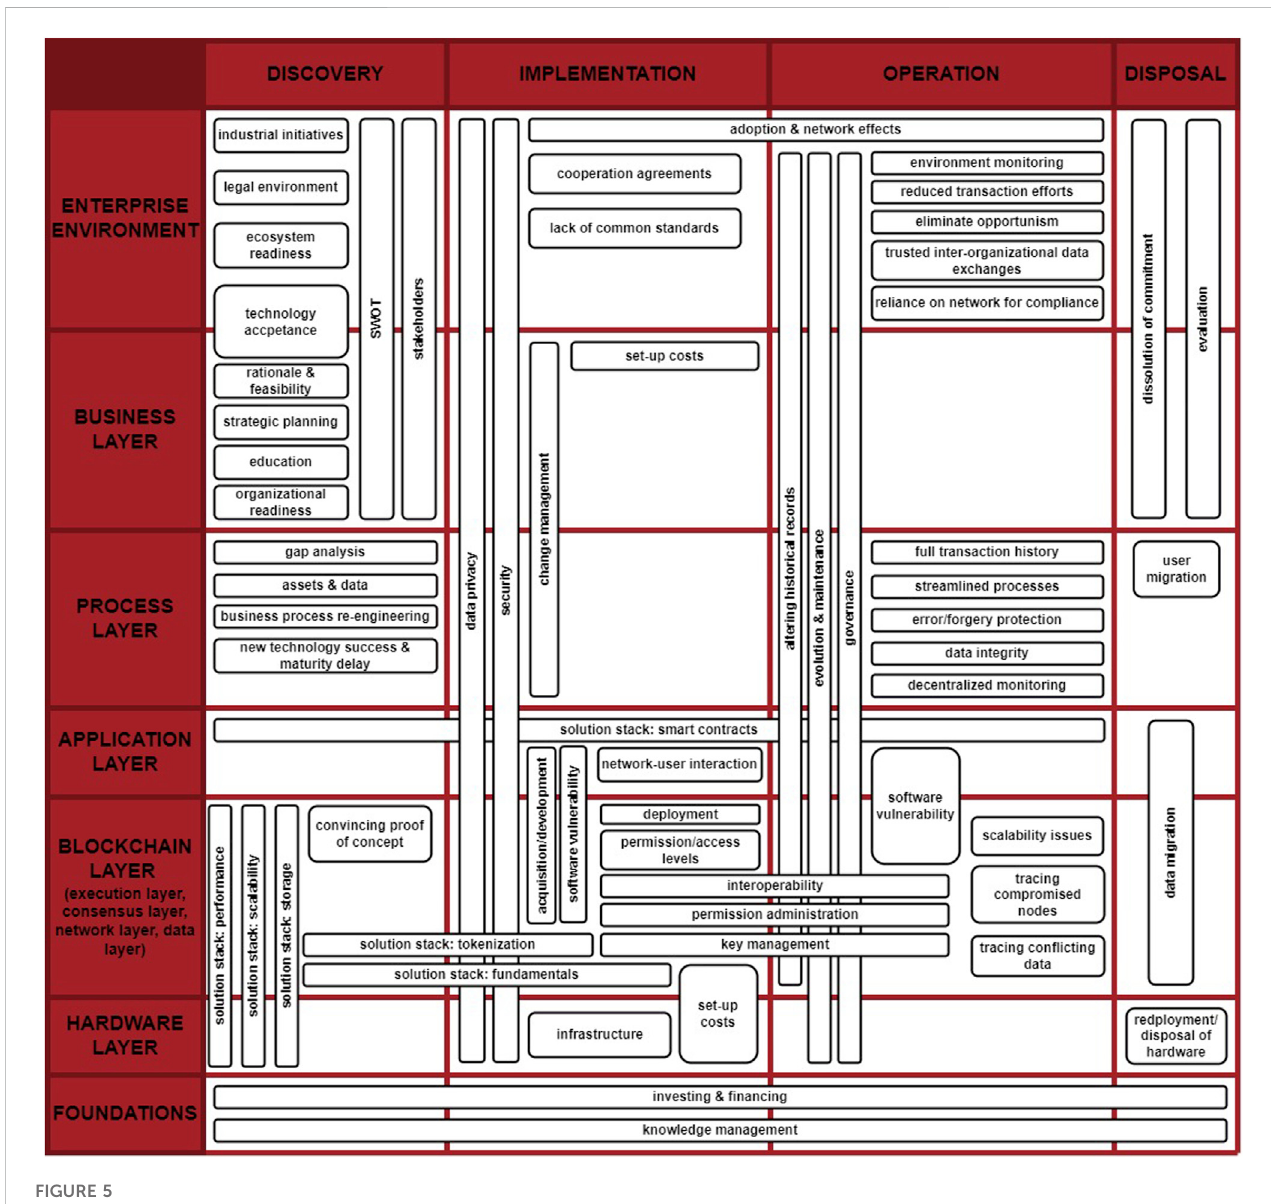
FIGURE 5 Reference Adoption Consideration